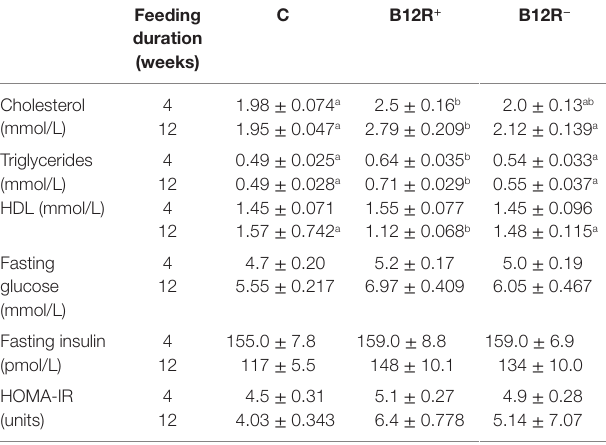
TaBle 2 | lipid profile, fasting glucose, and insulin levels and hOMa ir after 4 and 12 weeks of feeding. Feeding